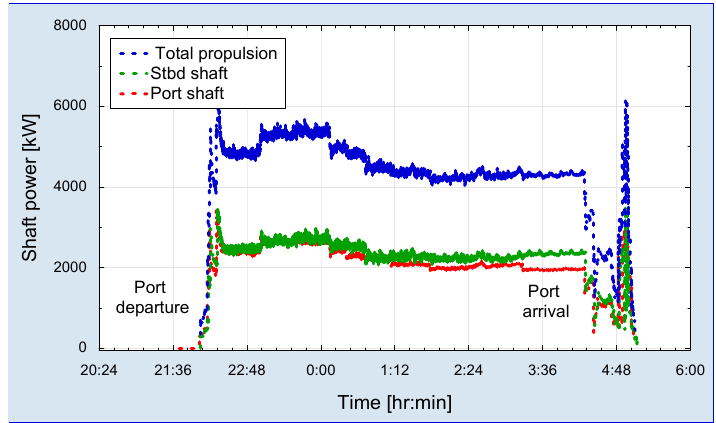
Figure 12. Single voyage propulsion power record.